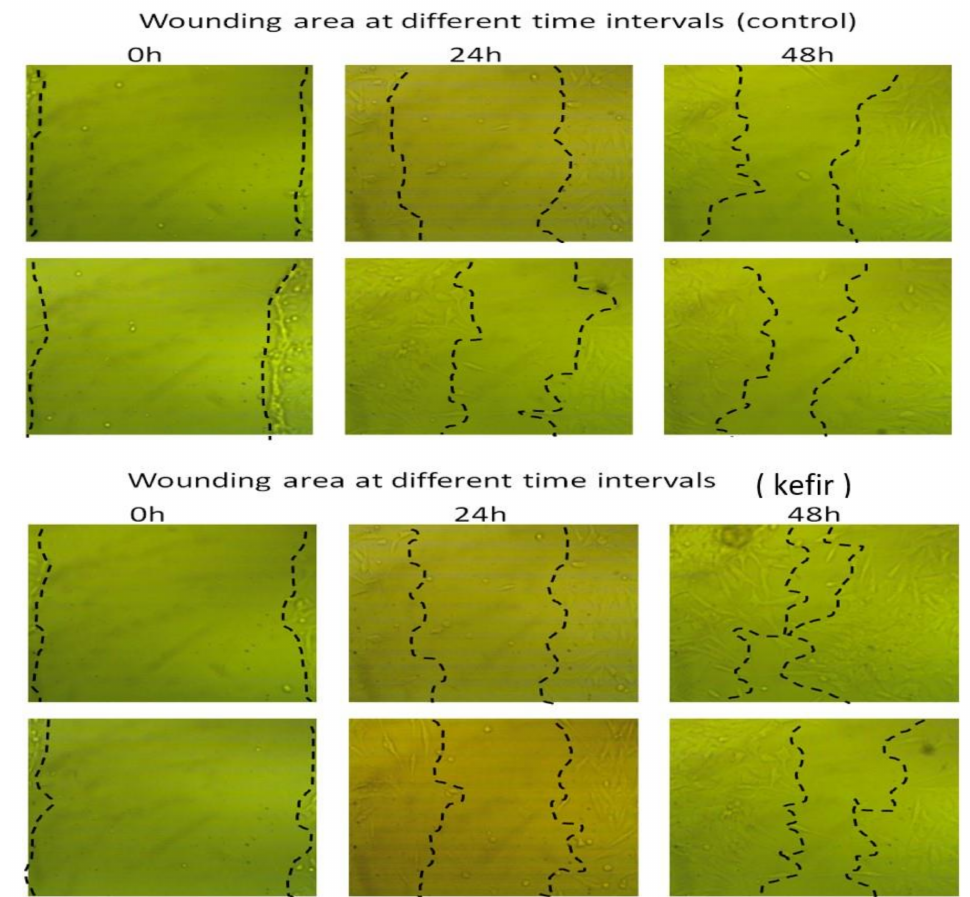
Figure 5. Wound-healing activities of kefir extract on human gastric epithelial cells (GES-1).